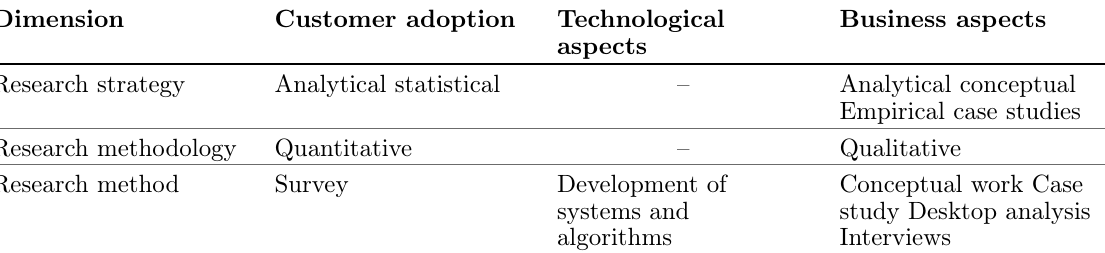
Table 19. Generalisation of the main trends in research strategy and methodology.